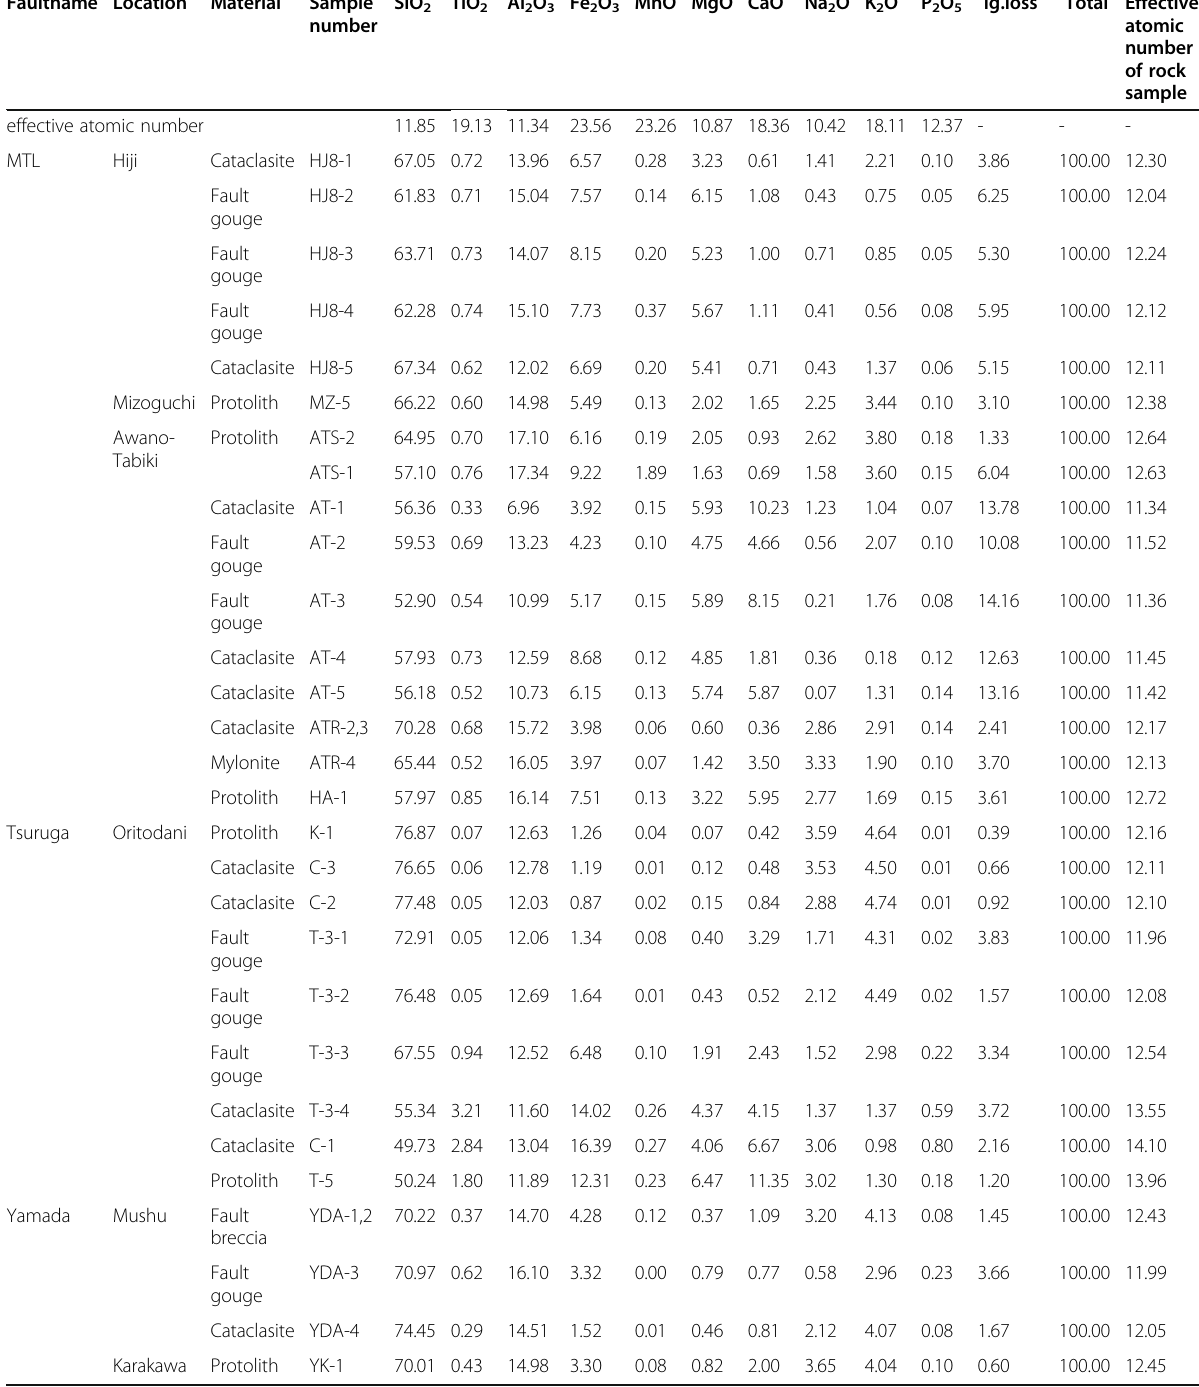
Table 3 XRF analysis and effective atomic number ( Z et ) results for the rock samples Faultname Location